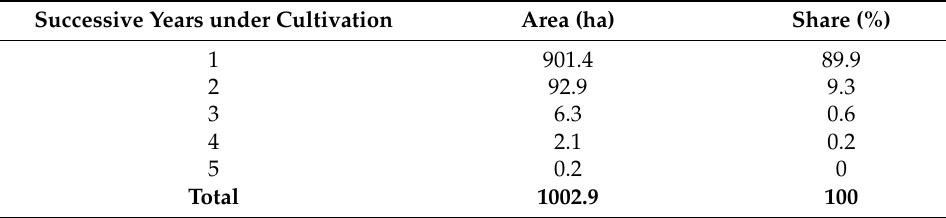
Table 5. Houaylack-Vangven rotation features, 2016–2020.